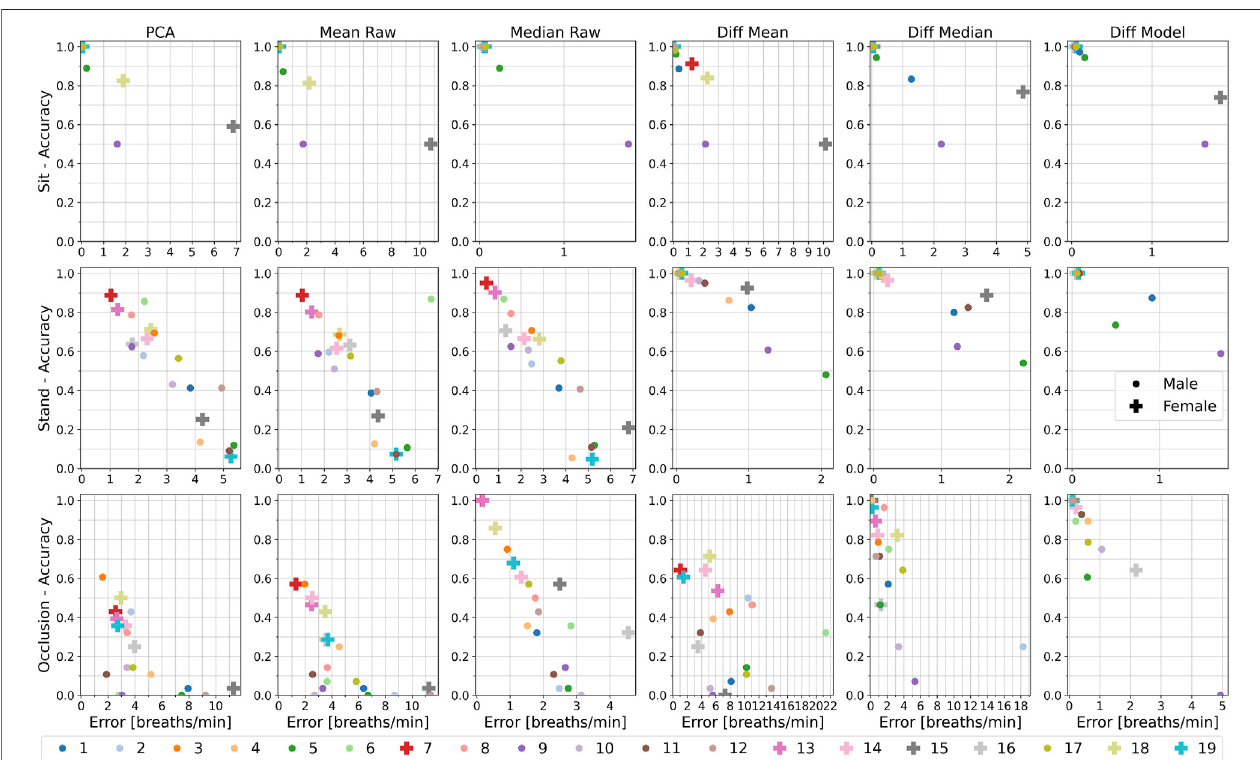
FIGURE10 | Themean accuracy ( y -axis) over the mean error ( x -axis) for all individual users, captured from the chest using aFast FourierTransform window with a lengthof48 s.Accuracyanderrorsareaveragedoveralldistances(1 – 4 m)andallrespiratoryrates(10and15 bpm)forthemethods(fromlefttoright):PCA,MeanRaw, Median Raw, Diff Mean, Diff Median, and Diff Model, each divided into the conditions sitting, standing, and occlusion. Each user is associated with a unique color where circles mark male and plus signs mark female users. Please note the different scales on the x -axis (errors). Ideally, all users are located at the top left corner, indicating a high accuracy and low error. This is for most participants achieved by all methods during the sitting condition. On other conditions, the Diff Model method achieves the best performance. The accuracy and errors can be seen to vary widely for certain participants, with especially user 9 standing out on all conditions and methods due to poorly adhering to the breathing visualization.